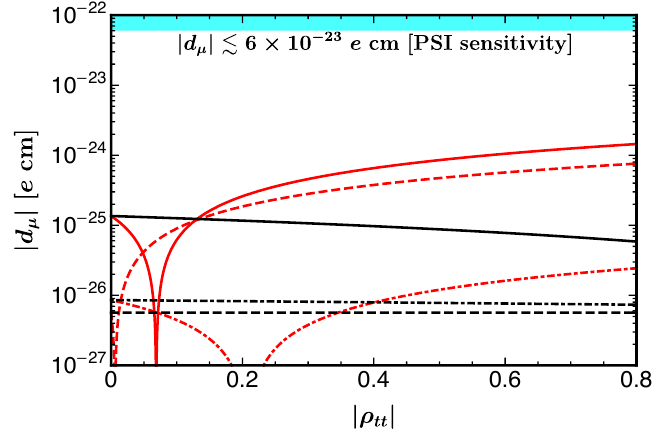
Figure 3 . Different two-loop contributions to | d µ | as function of ρ tt , with c γ = 0 . 1 , m H = m A = m = 300 GeV, and ρ µµ = iλ µ for illustration. Red (black) curves correspond to φ tt = H ± 0 ( π/ 2) . Solid, dashed, and dot-dashed curves represent contributions of | d φγ